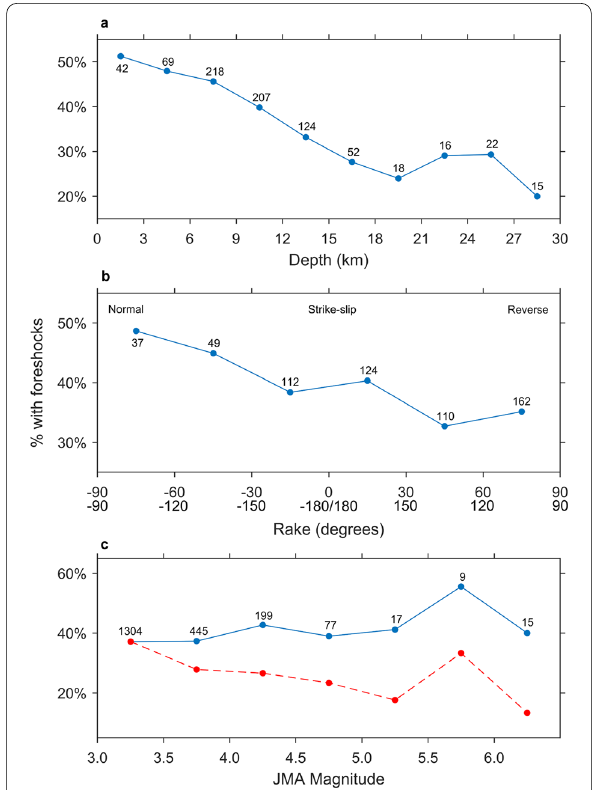
Fig. 6 Percentages of foreshock occurrence shown as functions of a depth, b rake and c magnitude. The numbers above the points give the total number of earthquakes for which the percentage was calculated. In c the blue line shows the percentage using all the data. The red dashed line shows the percentage using only foreshocks within a range of 2 magnitude units from the mainshock